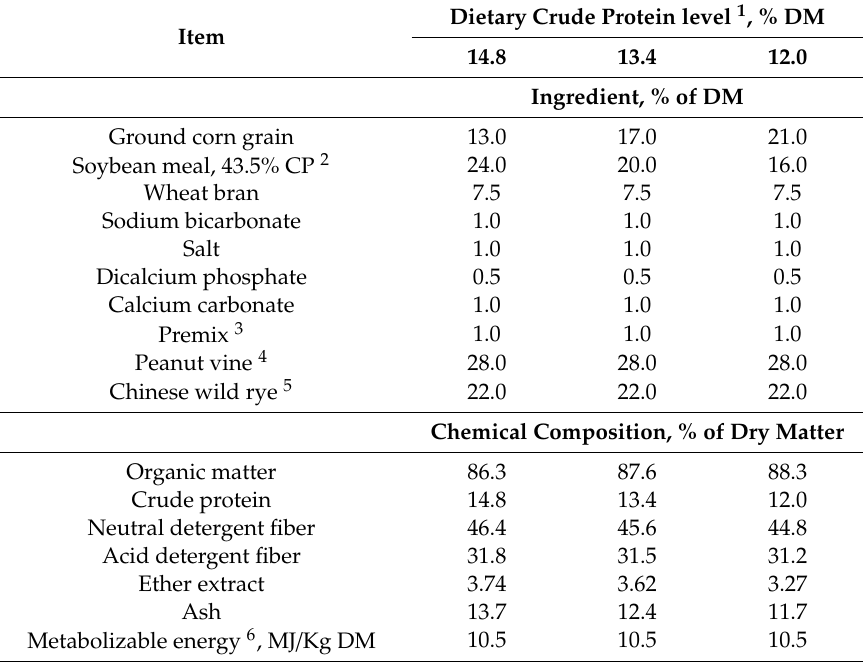
Table 1. Ingredients and chemical composition of the experimental